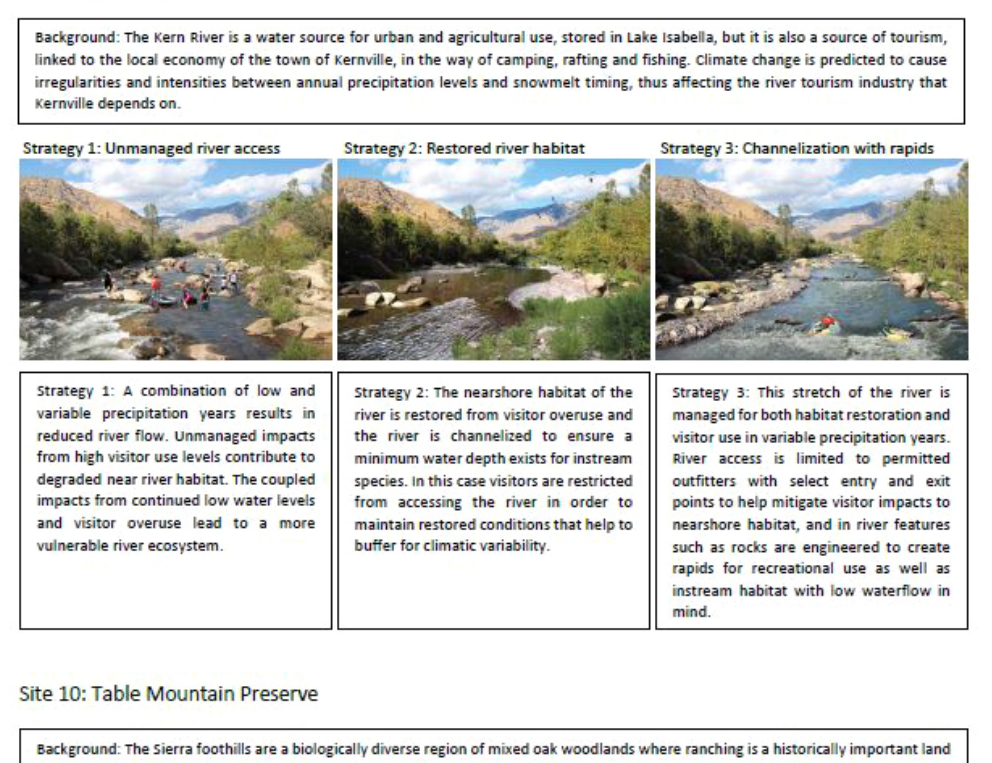
Fig. 5 . Text versions of scenarios for site 2 – Upper Kern River, and site 10 – Table Mountain Preserve as seen in the survey. The nontext survey version did not include explanatory background and strategy content, just titles and images for each of the three strategies per